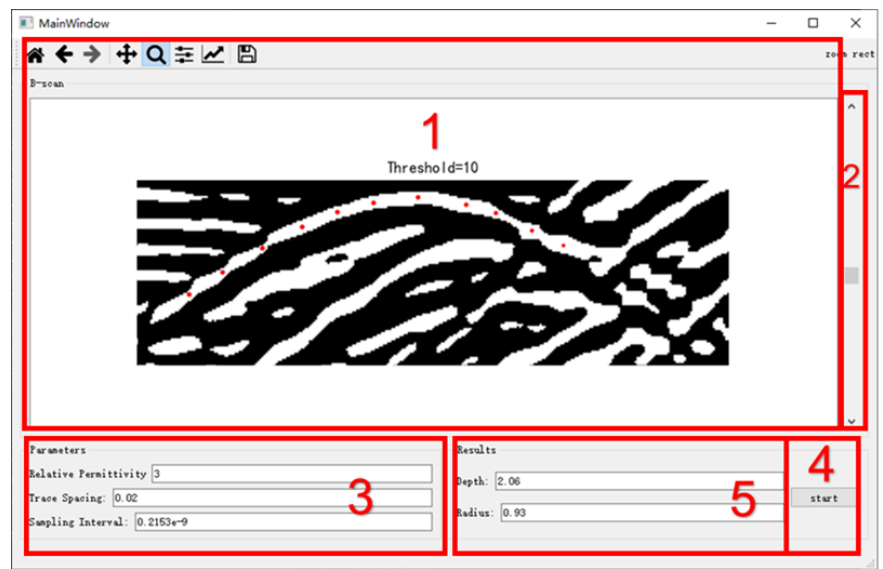
Figure 9. Graphical user